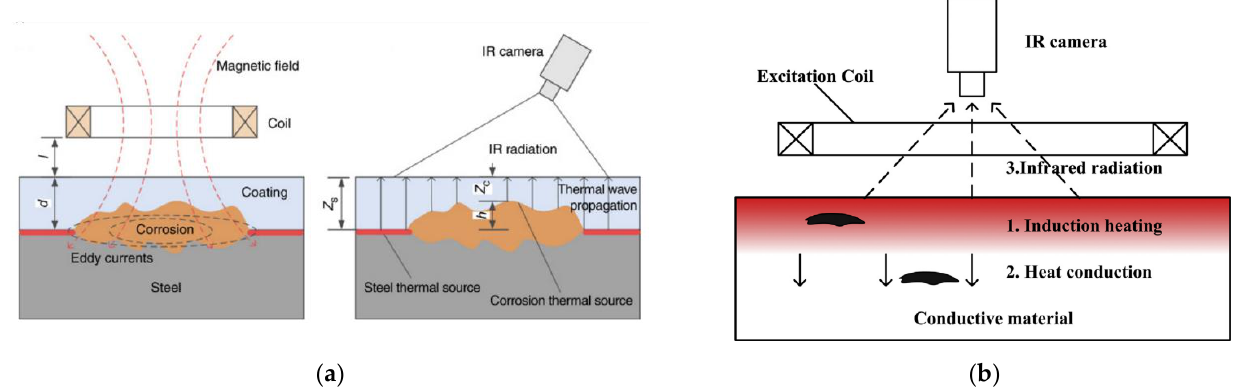
Figure 10. The principle of eddy current thermography for use in ( a ) corrosion detection and ( b ) generic defect detection. (Reprinted with permission from ref. [55,56]. Copyright 2017 and 2014 Elsevier).